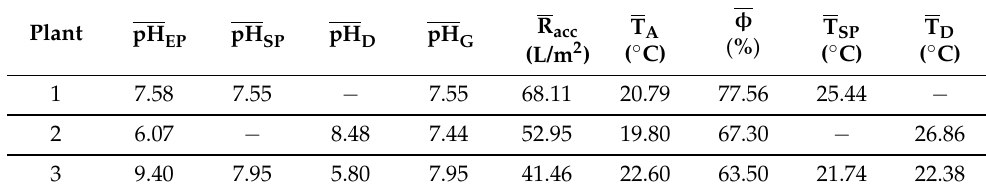
Table 4. Average values ( pH , R acc , φ , T